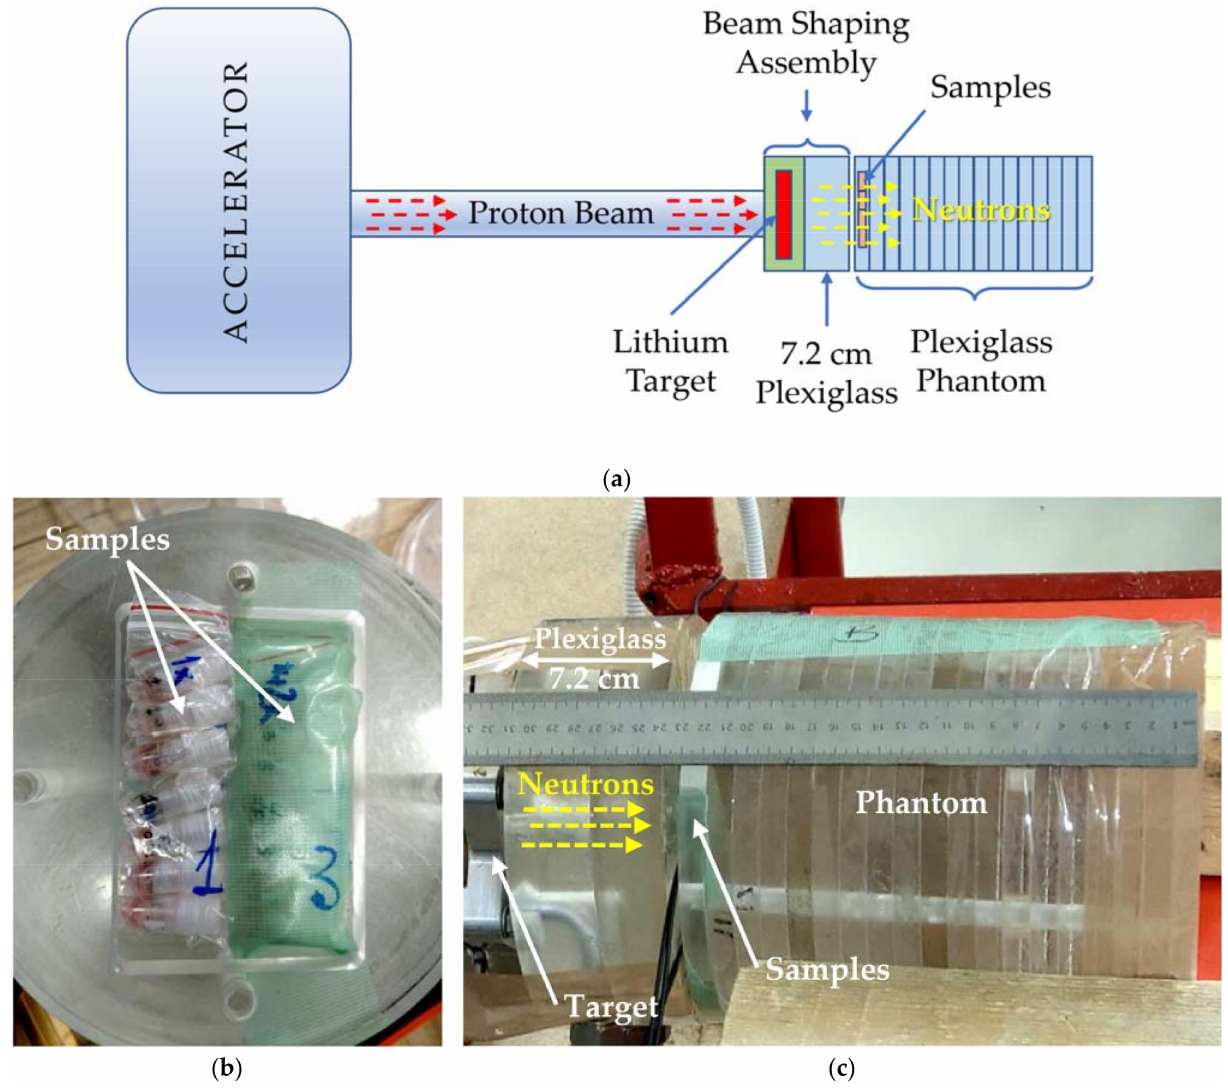
Figure 2. Irradiation settings. Schematic illustration of BNCT accelerator components and irradiated samples ( a ). Cells in vials were placed in the first layer of the plexiglass phantom ( b ). The phantom was oriented horizontally with a 7.2 cm plastic layer between the neutron-producing target and the cells ( c